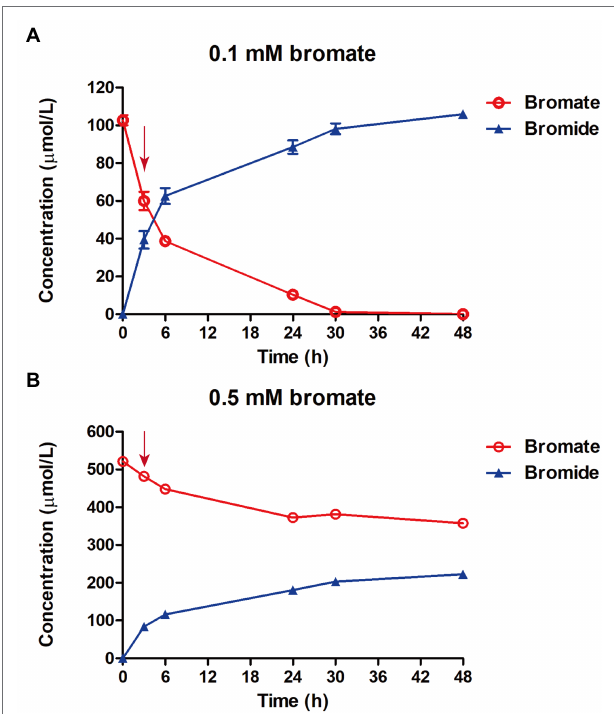
FIGURE 4 | Determination of bromate reduction in strain K. variicola Glu3 with 0.1 mm (A) or 0.5 mm (B) of bromate dosage. Error bars represent the estimated standard deviations for triplicate samples and were not shown if less than the size of the symbol. Red arrow indicates the sampling time for RNA sequencing at 3 h after bromate